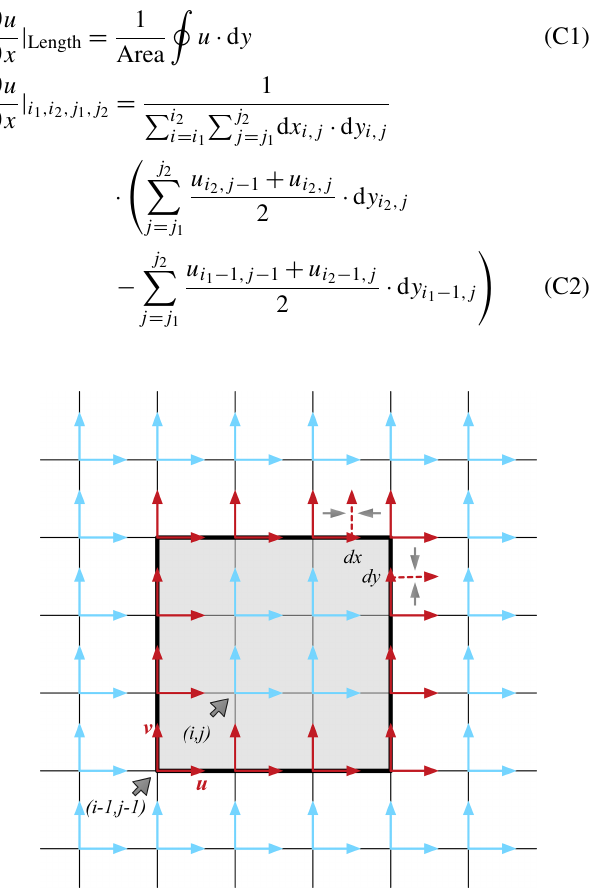
Figure C1. Example for spatial scaling analysis with a local area of 9 (i.e., 3 × 3) model cells. The horizontal (or vertical) direction is in the model’s eastern (or northern) direction, indexed by dis- crete indices of i (or j ). The sea ice drift velocities that are used to compute the line integral for ∂u and ∂v are marked in red. For ∂x ∂y contrast, other velocities are marked in blue. Since velocities are de- fined in the top right corner of each cell, they are interpolated on the cell edges to compute the integral. The interpolated velocities are marked by dashed vectors corresponding to the averaging operation in Eq.